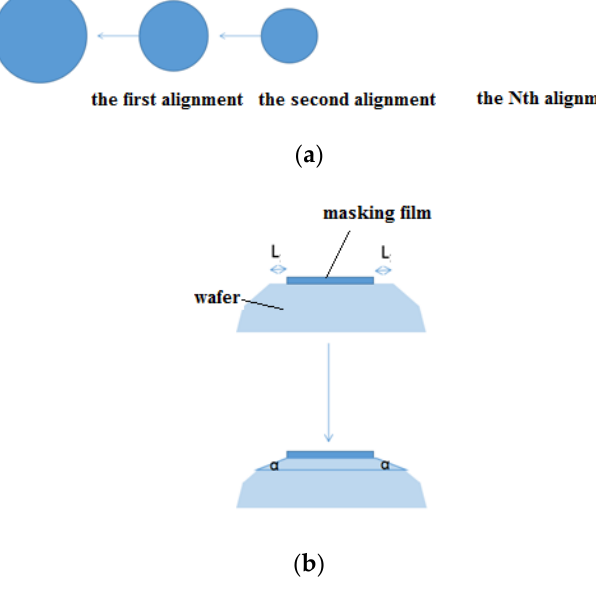
Figure 4. Schematic view of the process steps: ( a ) a circular mask with smaller diameter is aligned to a larger one successively to realize the approximate hemisphere model; ( b ) a circular truncated cone with perfect cutting edge angle on the top profile.